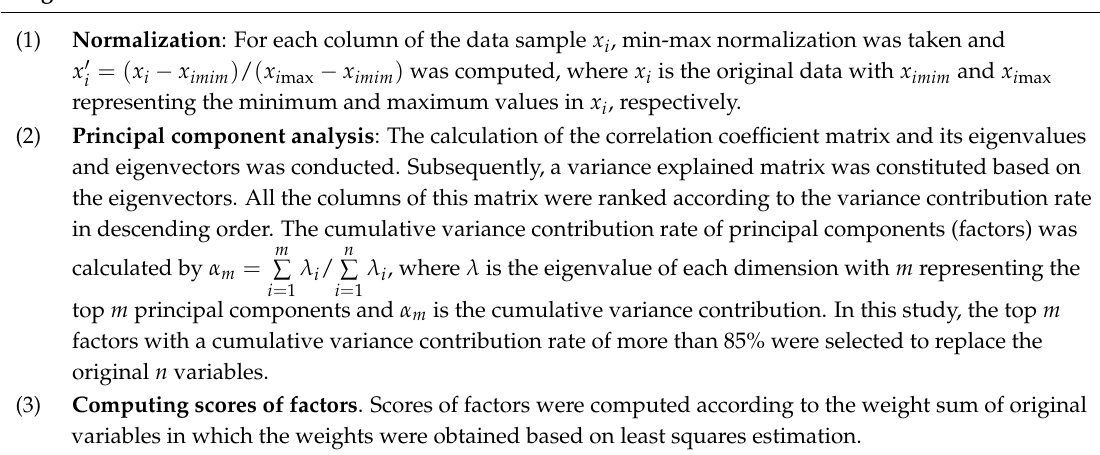
Algorithm 1. Factors extraction based on